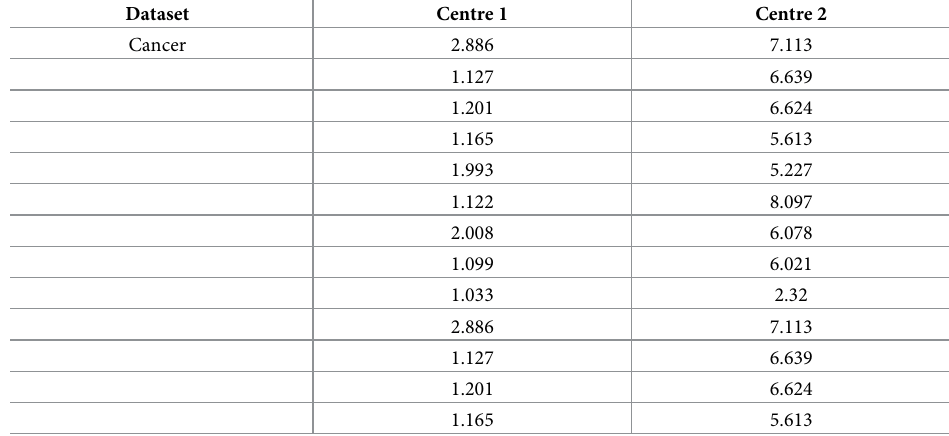
Table 7. The best clustering centres on the Cancer data set obtained by the AMADE algorithm.